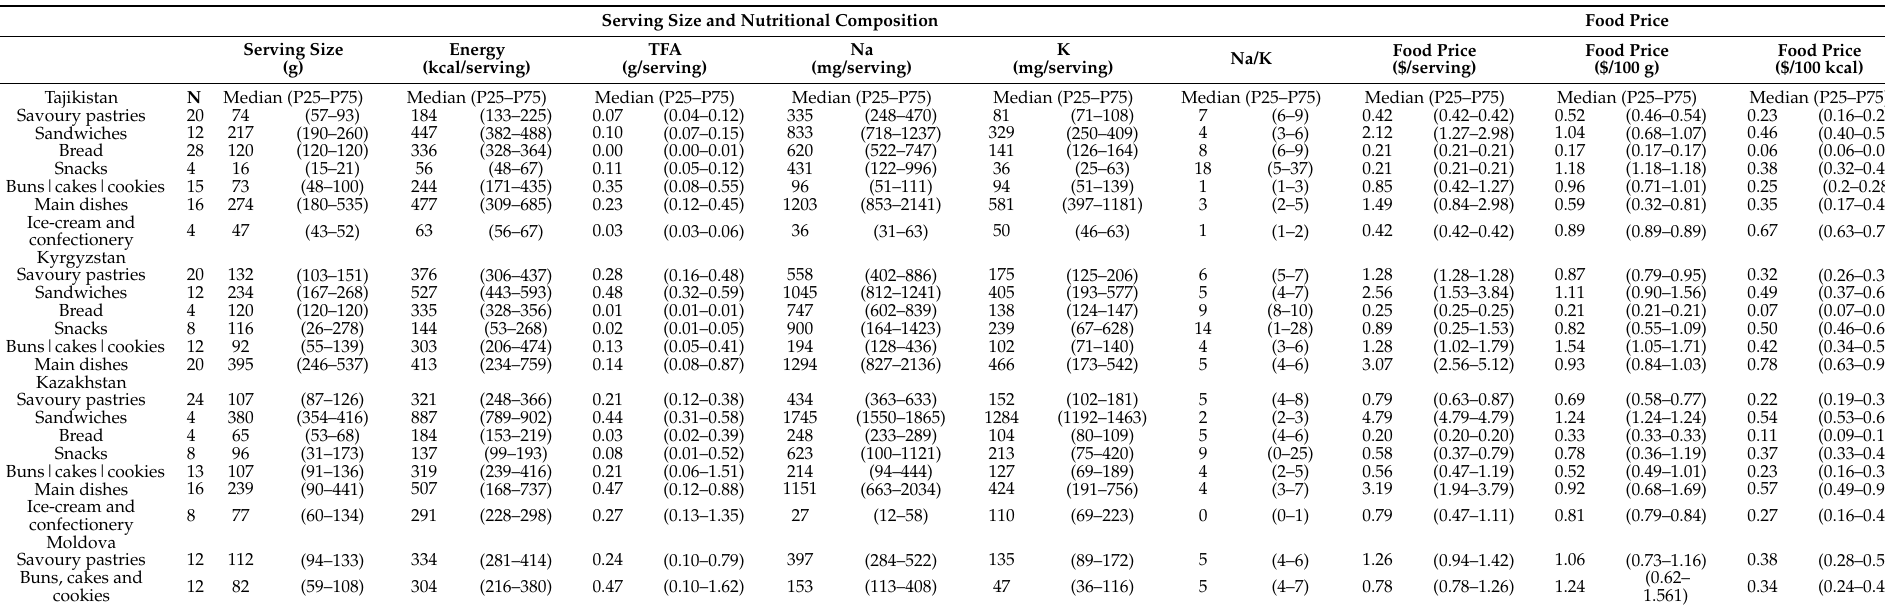
Table 2. Serving size, nutritional composition (energy, trans -fatty acids, sodium, potassium and sodium–potassium ratio) and price (per serving, per 100 g and per 100 kcal) of the